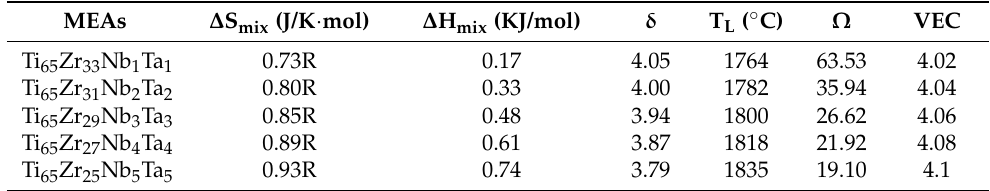
Table 3. A list of nomenclature for all the Greek letters and symbols used in the study. Greek Letters and Symbols Common Interpretation ∆ S mix Mixing entropy ∆ H mix Mixing enthalpy Difference in atomic radius of alloying δ elements T L Melting point Ω Body-centered cubic structure α (cid:48)(cid:48) Orthorhombic